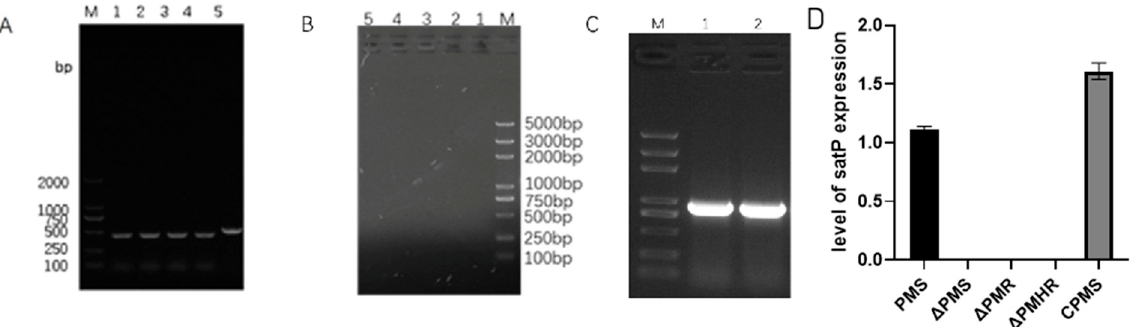
Figure 2. ( A ) Confirmation that the deletion of the satP strains were genetically stable beyond 40 generations by PCR. M: DL 2000 Marker; 1–4, deletions strain satP ; 5, wild-type strain. ( B ) The genetic stability of satP -deficient strains over 40 generations was verified by pRE112 primers. M: 2000 plus DNA Marker; 1–4, deletions strain satP ; 5, wild-type strain. ( C ) Confirmation that the CPmS was genetically stable beyond 40 generations by PCR. M, 2K plus DNA Marker; 1, wild-type strain; 2, CP m. (All data are expressed as the mean ± SD. n = 3). ( D ) The expression level of the satP gene in the wild-type strain, deletion strains and CPmS .